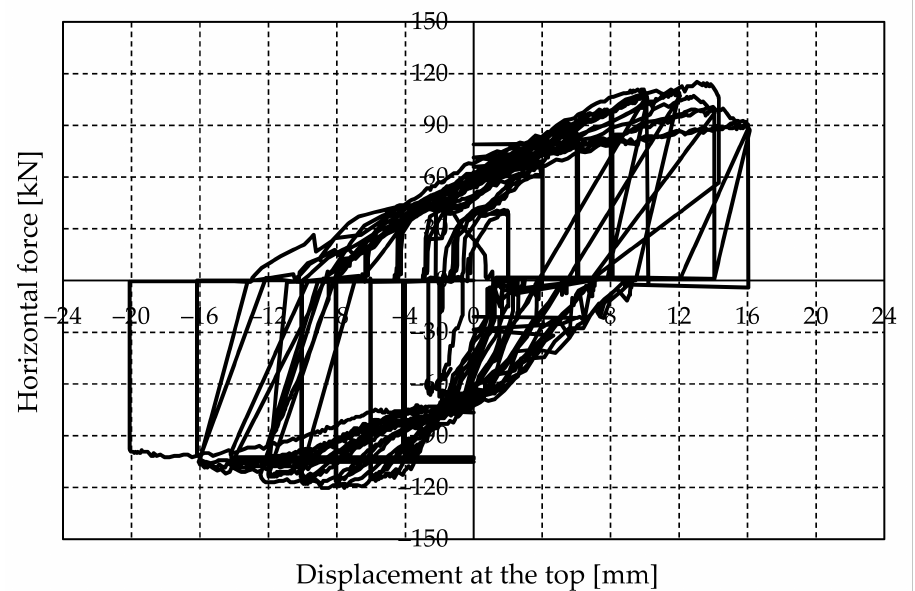
Figure 13. Force—displacement diagram for W2 (V = 230 kN, σ v = 0.4 N/mm 2